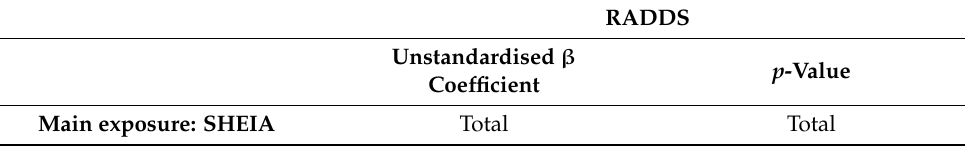
Table 3. Association between SHEIA and